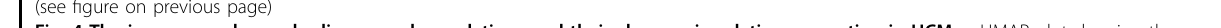
Fig. 4 The immune and vascular lineage subpopulations and their changes in relative proportion in HCM. a UMAP plot showing the subpopulations of the immune lineage. b Expression of established markers for macrophages ( CD68 ), T cells ( CD3D ), Natural killer cells ( NCR1 ), and B cells ( CD79A ) in each immune subpopulation. c Expression of the marker for each of the fi ve macrophage subpopulations. d Relative proportion of each subpopulation in macrophages of each condition. + : expansion; -: contraction. e UMAP plot showing the cytotoxicity and naiveness scores for each immune nucleus. The cytotoxicity and naiveness scores were calculated by summing the expression of previously reported signatures for T cell cytotoxicity ( PRF1 , IFNG , GNLY , NKG7 , GZMB , GZMA , GZMH , KLRK1 , KLRB1 , KLRD1 , CTSW , and CST7 ) and naiveness ( TCF7 , SELL , LEF1 , and CCR7 ) 51 . f Relative proportion of each subpopulation of T/NK cells in each condition. g UMAP plot showing the subpopulations of the vECs. h Expression of the established markers for venous Ecs ( ACKR1 and NR2F2 ), arterial Ecs ( SEMA3G and DLL4 ), capillary Ecs ( RGCC and CA4 ), and immune Ecs ( CX3CL1 and CCL2 ). i Relative proportion of each subpopulation in the vECs from each condition. j UMAP plot showing the subpopulations of the SMCs. k Molecular signature for each SMC subpopulation. l Expression of contractile markers CNN1 and TAGLN in each SMC subpopulation. m Relative proportion of each subpopulation in the SMCs from each condition. n UMAP plot showing the subpopulations of the pericytes. o Molecular signature for each pericyte subpopulation. p Relative proportion of each subpopulation in the pericytes from each condition. MAC: macrophage; SMC: smooth muscle cell; vEC: vascular endothelial